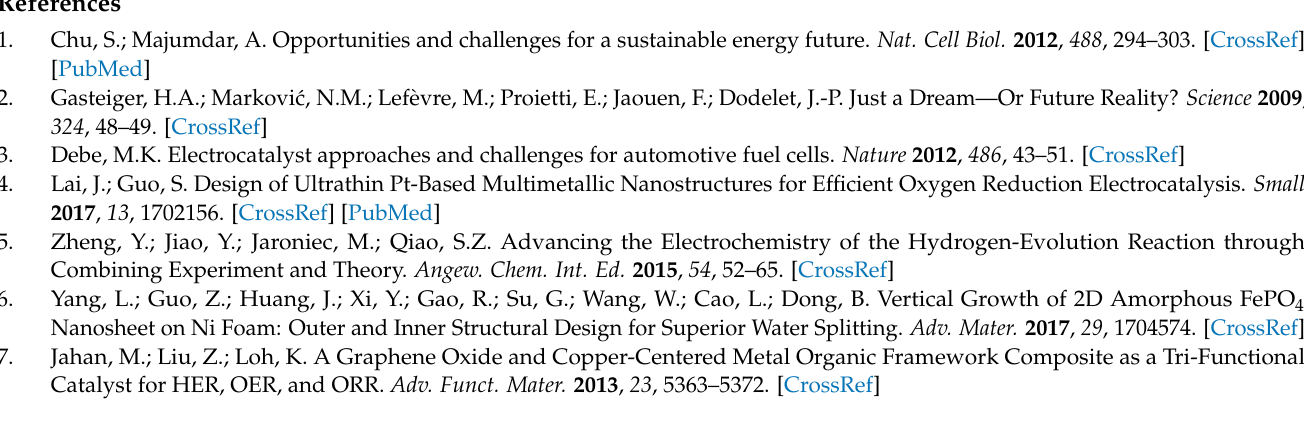
10.3390/nano11092237/s1, Figure S1: Scanning electron microscope (SEM) images of ZIF-67 (a,b) and Co 3 S 4 /Co(OH) 2 /ZIF-67 (c,d); Figure S2: (a) X-ray diffraction pattern (XRD) of ZIF-67 and Co 3 S 4 /Co(OH) 2 /ZIF-67, (b) FTIR spectrum of as-prepared Co 3 S 4 /Co(OH) 2 /ZIF-67 precursor; Figure S3: EDS analysis of ZIF-67; Figure S4: EDS analysis of Co 3 S 4 /Co(OH) 2 /ZIF-67; Figure S5: X-ray photoelectron spectroscopy (XPS) spectra of Co 3 S 4 /Co(OH) 2 /ZIF-67 precursor, (a) Co 2p, (b) S 2p, (c) C 1s, (d) O 1s; Figure S6: (a–f) HRTEM images and profile of the lattice fringes of ODR-Co 9 S 8 /CoO/NC heterostructure; Figure S7: EDX analysis of ODR-Co 9 S 8 /CoO/NC; Figure S8: CV curves of (a) ODR-Co 9 S 8 /CoO/NC, (b) Co 3 S 4 /Co(OH) 2 /ZIF-67 and (c) ZIF-67 for OER and (d) ODR-Co 9 S 8 /CoO/NC, (e) Co 3 S 4 /Co(OH) 2 /ZIF-67 and (f) ZIF-67 for HER; Figure S9: ECSA normalized LSV curves of ODR-Co 9 S 8 /CoO/NC in comparative to reference samples for (a) OER and (b) HER; Figure S10: (a) The mass activity of OER catalysts at 250 mV and (b) HER catalysts at 200 mV; Figure S11: (a,b) OER and HER polarization curves of ODR-Co 9 S 8 /CoO/NC at different scan speeds; Figure S12: The XRD spectrum of the ODR-Co 9 S 8 /CoO/NC heterostructures after electrocatalytic test; Figure S13: (a,b) OER and HER performance of Co 9 S 8 /CoO/NC-450 and Co 9 S 8 /CoO/NC-650. (c) EPR spectrum of Co 9 S 8 /CoO/NC-450 and Co 9 S 8 /CoO/NC-650; Table S1: The surface elemental composition of the as-prepared ODR-Co 9 S 8 /CoO/NC heterostructures according the XPS measure- ments; Table S2: Comparison of electrochemical surface area (ECSA) of ODR-Co 9 S 8 /CoO/NC